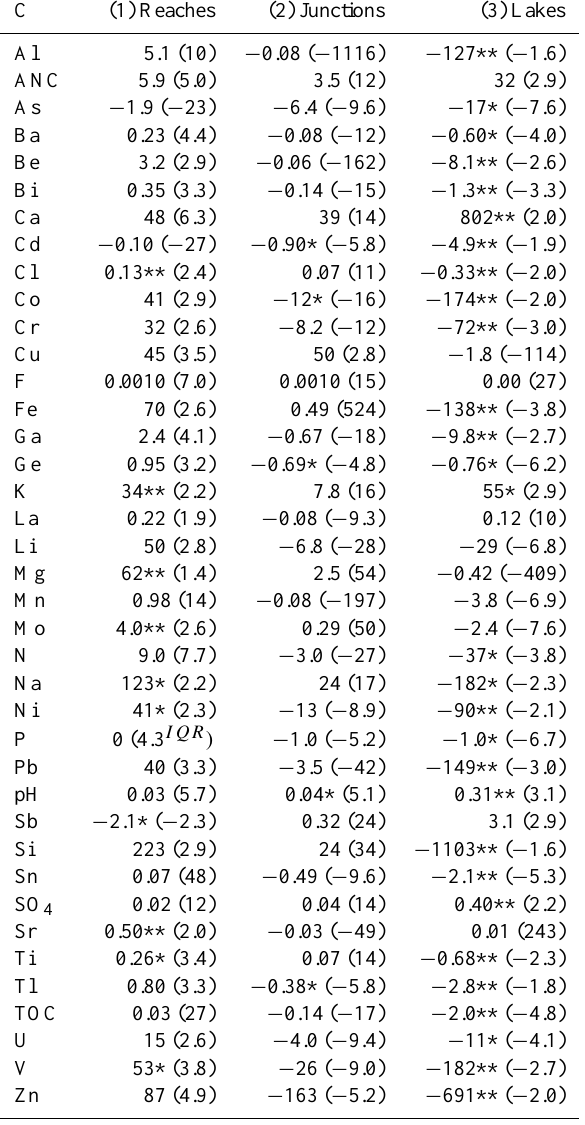
Table 3. Median and robust coefficient of variation (CV) of the dif- ference between (1) stream reaches ( n = 40), (2) stream junctions (53 junctions with 107 tributaries vs. downstream comparisons) and (3) lakes (36 lakes with 77 inlets vs. outlets comparisons). Signif- icant differences using both Wilcoxon and paired Student’s t test are marked with * for p < 0.05 and ** for p < 0.01. For units, see